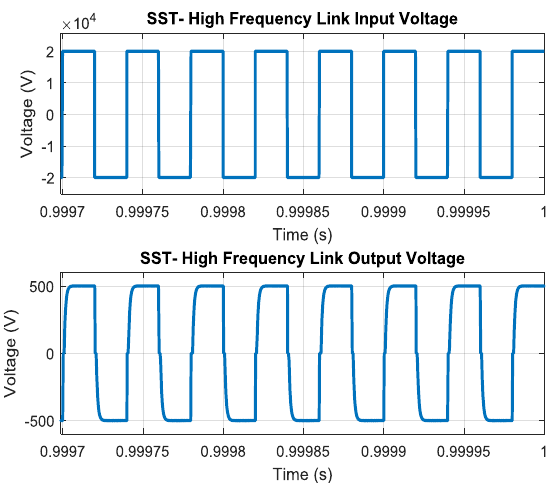
Figure 11. SST-VSC voltage and current at the DC -link.